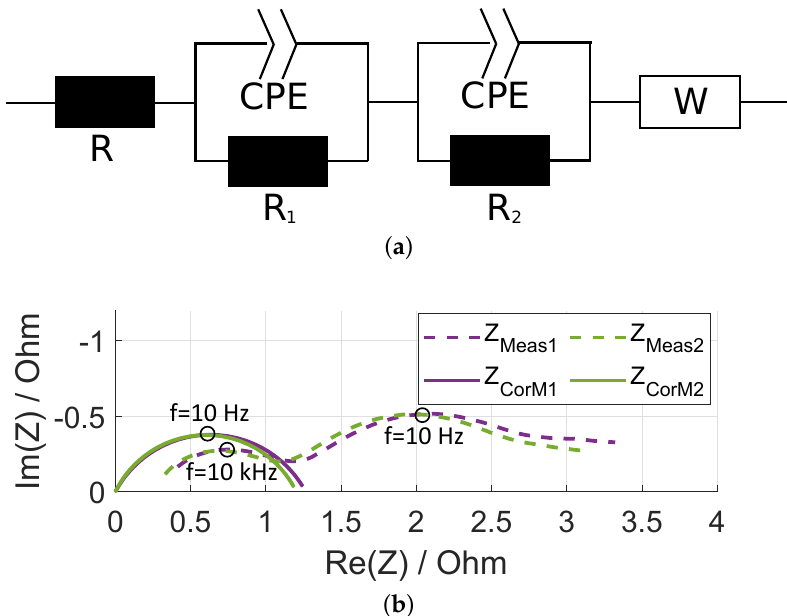
Figure 5. Reduction of electrochemical impedance spectra to charge transfer processes: ( a ) Equivalent circuit model used to reduce the measured impedance to the charge transfer processes. ( b ) Impedance of measurements 1 and 2 (dashed) and the corresponding reduced spectra after subtracting internal resistance, inductance, and diffusion